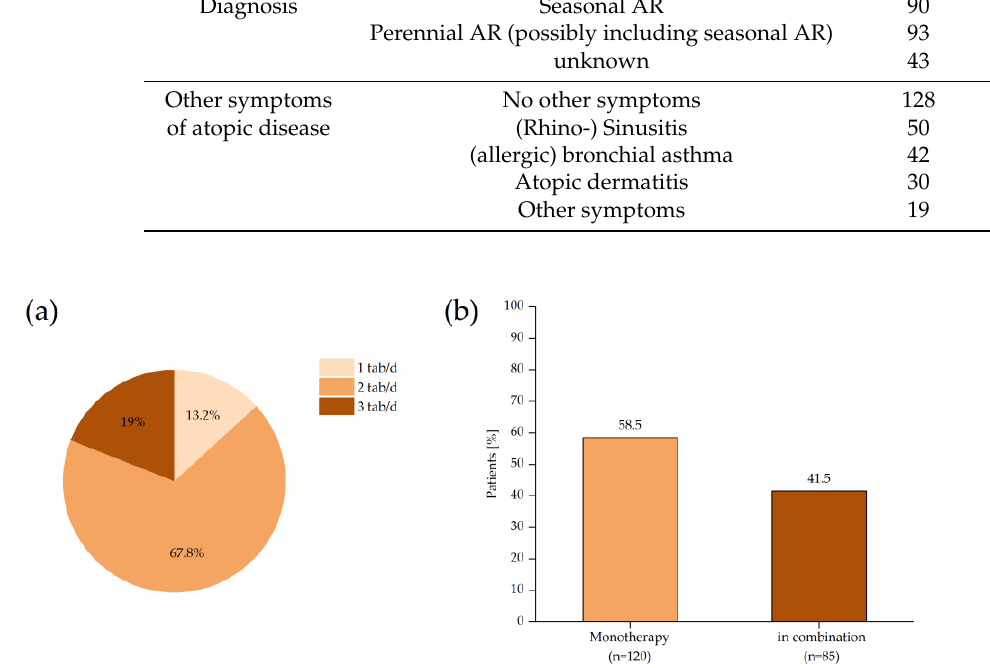
Figure 2. Individual allergens leading to allergic rhinitis symptoms ( n = 226). The majority of patients suffered from seasonal allergic rhinitis, which was often combined with perennial allergic rhinitis (Table 2, Figure 3). Table 2. Baseline medical history ( n = 226).